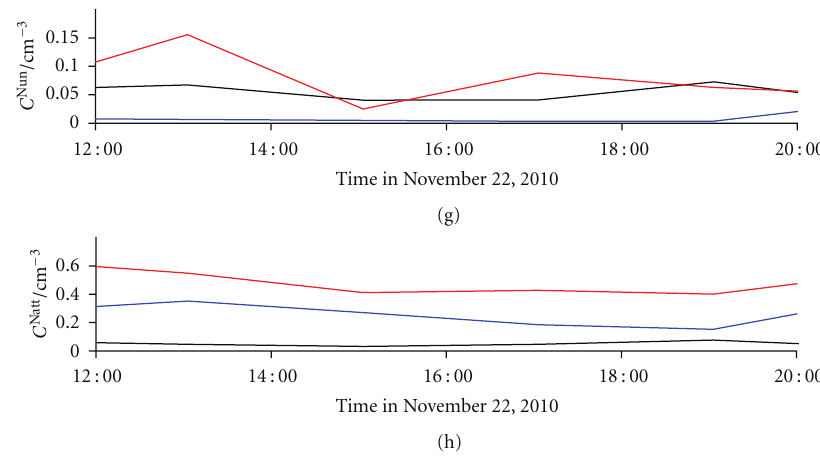
Figure 17: Time run of: (a) total number concentration of general aerosol particles ( C N (tot)) and geometric mean values of their diameters gen ( d GM ), (b) activity concentration of radon ( C A ) and equilibrium equivalent activity concentration of radon decay products ( C A ), (c) Rn RnDP number fraction of particles smaller than 10 nm ( x gen ( < 10)) and smaller than 20 nm ( x gen ( < 20)), (d) activity fraction of the unattached RnDP , C Aun 214 , and ( f un ) and number fraction of the unattached RnDP ( x un ), (e) activity concentrations of the unattached RnDP atoms ( C Aun 218 Pb Po C Aatt C Aatt C Aatt C Aun 214 Bi ), (f) activity concentrations of the attached RnDP atoms ( 218 Po , 214 Pb , and 214 Bi ), (g) number concentrations of the unattached , C Nun 214 , and C Nun 214 ), and (h) number concentrations of the attached RnDP atoms ( C Natt 218 , C Natt 214 , and C Natt 214 ), in RnDP atoms ( C Nun 218 Pb Bi Pb Bi Po Po indoor air on November 22 (cooking a “risotto” dish from 14:20 to 15:00).